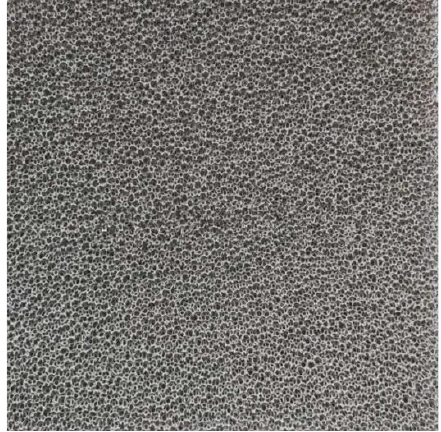
Figure 2. Diagram of Non-thermal plasma (NTP) with Porous Material.